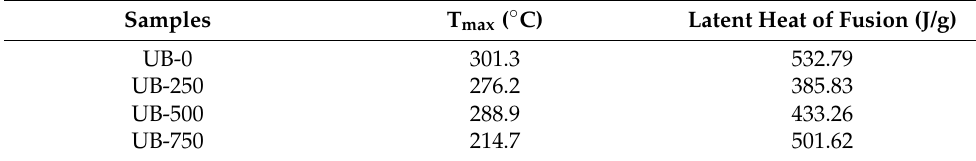
Figure 4. ( a ) Thermogravimetric (TGA) and ( b ) differential thermal analysis (DTA) curve for nonson- icated and sonicated BC film. Table 2. T max and latent heat of fusion for different BC